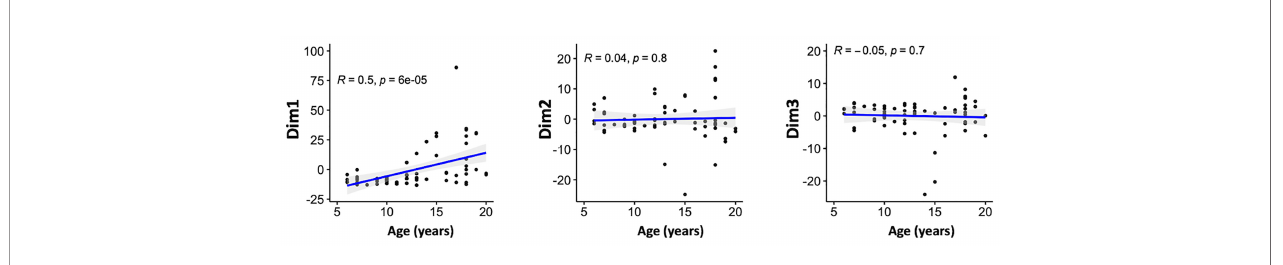
FIGURE 4 | Associations between the antibody responses and age. Correlation between the scores of the principal components 1 – 3 and age (in years) of the participants. Blue line represent linear regression lines and shading represents 95% con fi dence intervals. Only the fi rst principal component (Dim1) correlated